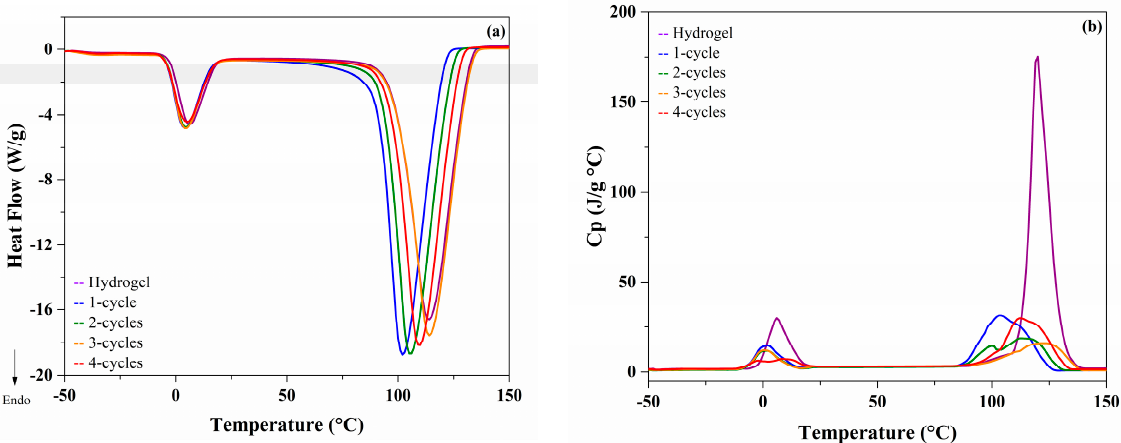
Figure 4. Thermograms of xanthan samples ( a ) Heat flow; ( b ) Specific heat